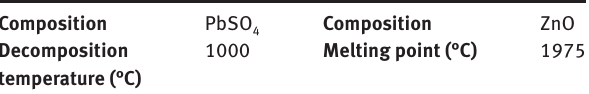
Table 3: Melting point, decomposition temperature of lead and